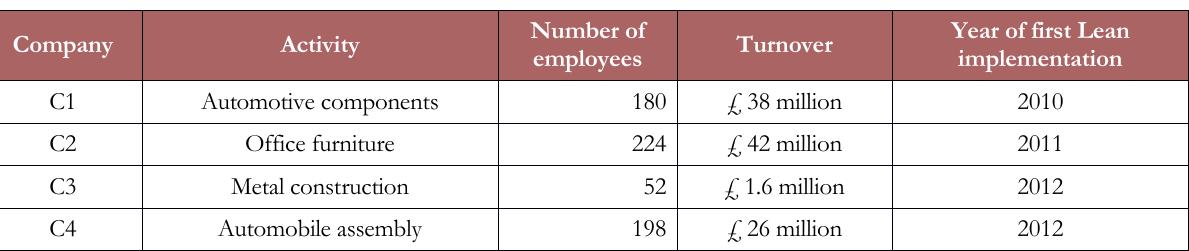
Table 2. Main characteristics of the